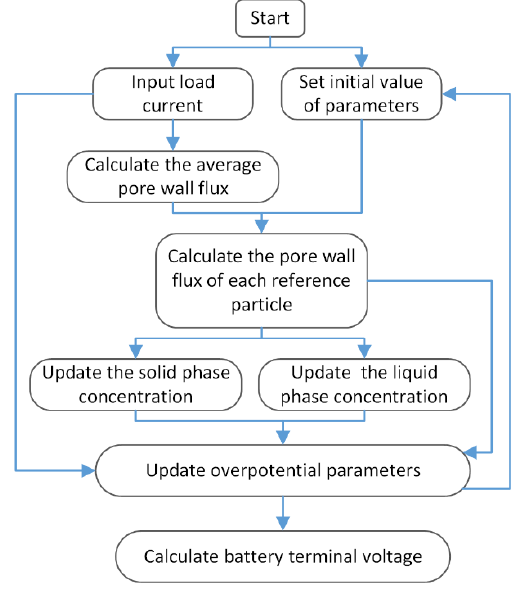
Figure 3. Simulation flow chart of the SMP model. Table 3. Battery model simulation parameters and their values.